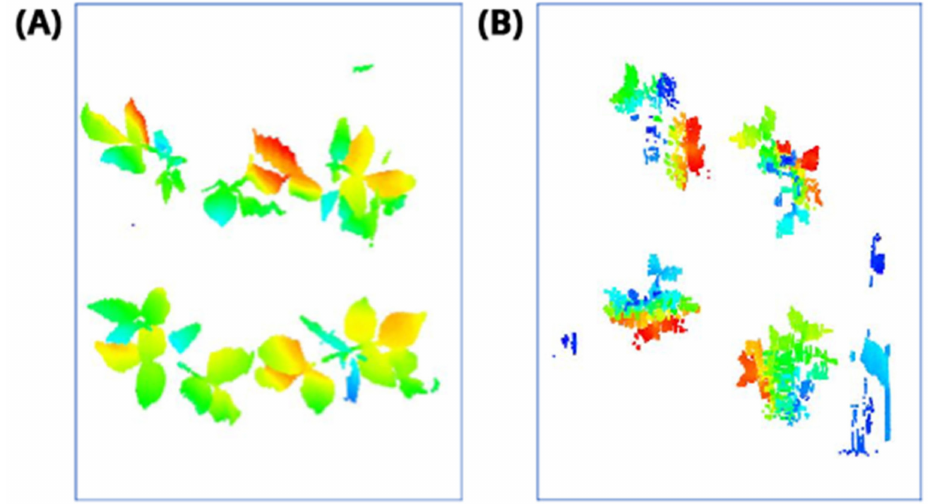
Figure 8. Outputs of Rasterization process—mung bean ( A ), chickpea ( B ). In this process, 3D point cloud data are converted into 2D images according to their height values. Shades of red represent data with a higher height value, medium heights are green, and the bottom ones have shades of